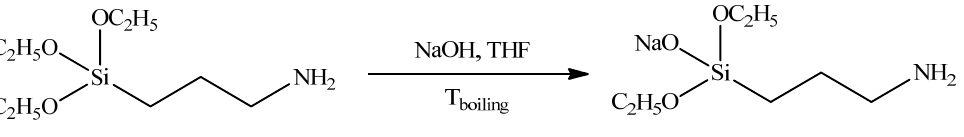
Figure 1. Synthesis of sodiumoxy-(3-aminopropyl)diethoxysilane.